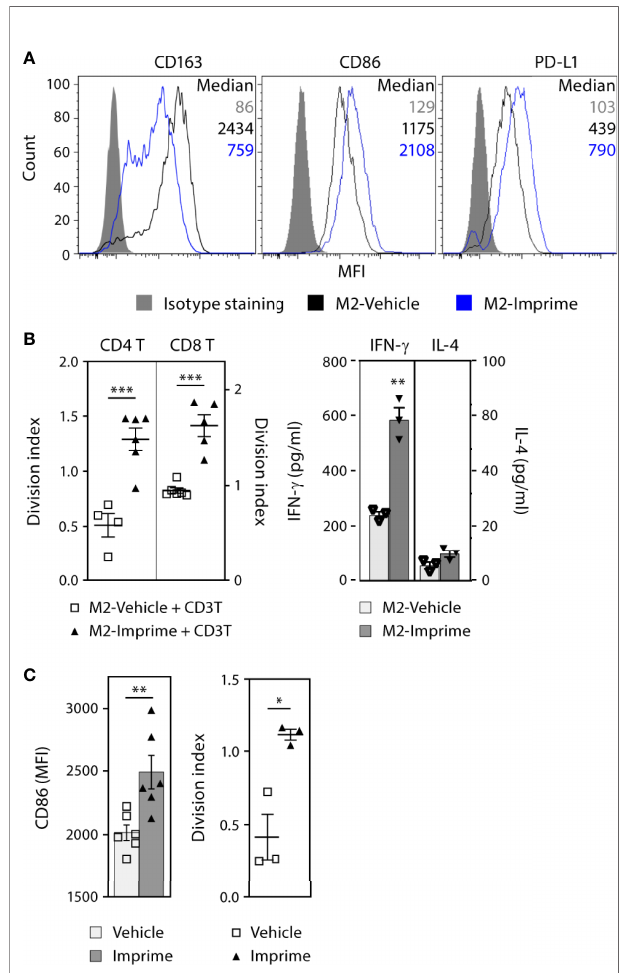
FIGURE 4 | Imprime activates the phenotype and functional state of ex vivo human MDMs and MDSCs. MDMs were prepared from monocytes as described in Materials and Methods (A) Phenotype of vehicle- or Imprime- treated MDMs was assayed by fl ow cytometry. (B) CD3 & CD28-stimulated CFSE-labeled autologous CD3 T cells were cultured with MDMs for 5 days; T cell proliferation was measured by fl ow cytometry, and IFN- g and IL-4 production was analyzed by ELISA. (C) MDSCs were prepared from human cord blood as described in Materials and Methods. CD86 expression on MDSCs and functional assessment in a T cell suppression assay were analyzed by fl ow cytometry. Representative results from ≥ 2 experiments are shown. All summary data are presented as mean ± SEM. Unpaired Student ’ s t test was used. * p < 0.05, ** p < 0.01, *** p <